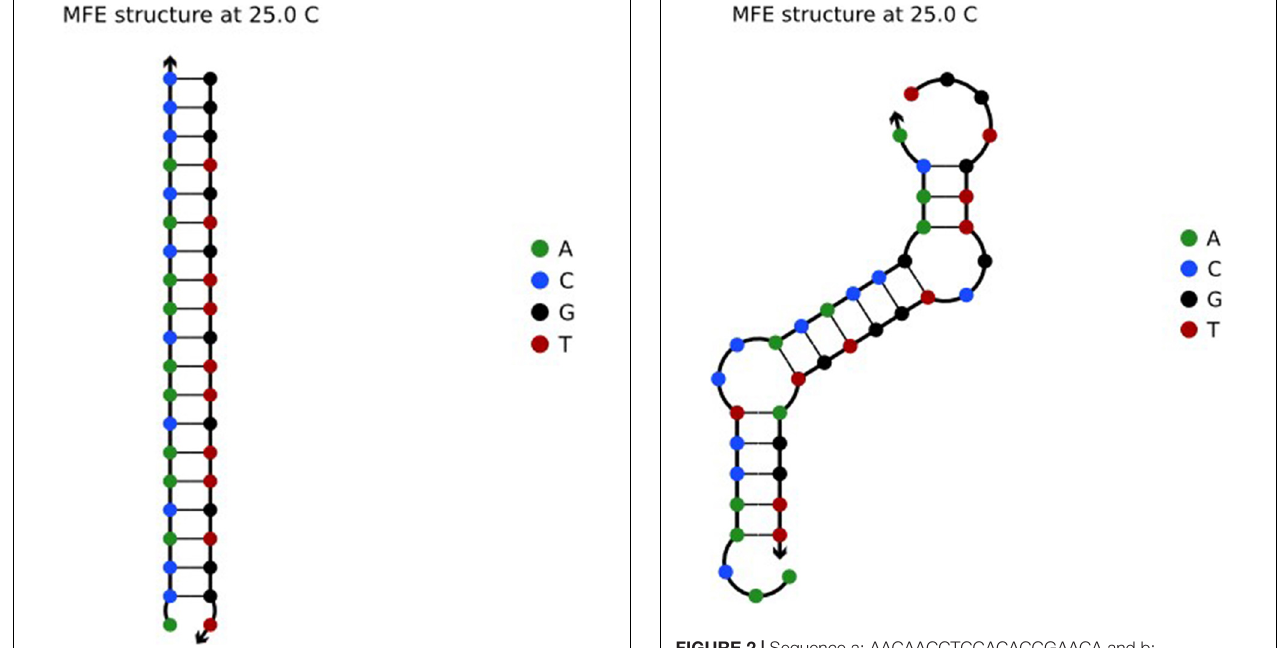
FIGURE 2 | Sequence a: AACAACCTCCACACCGAACA and b: TGGTGTTGCTGGTGTAGGTT. As shown in Figure 1 , one end of the sequence is